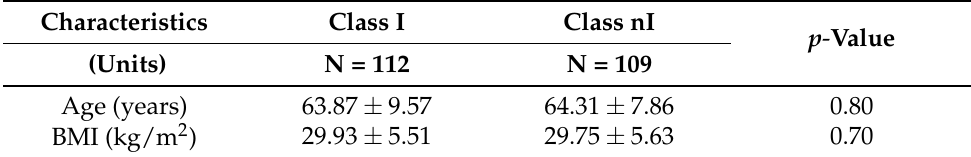
Table 1. Demographic characteristics of the participants within each class.